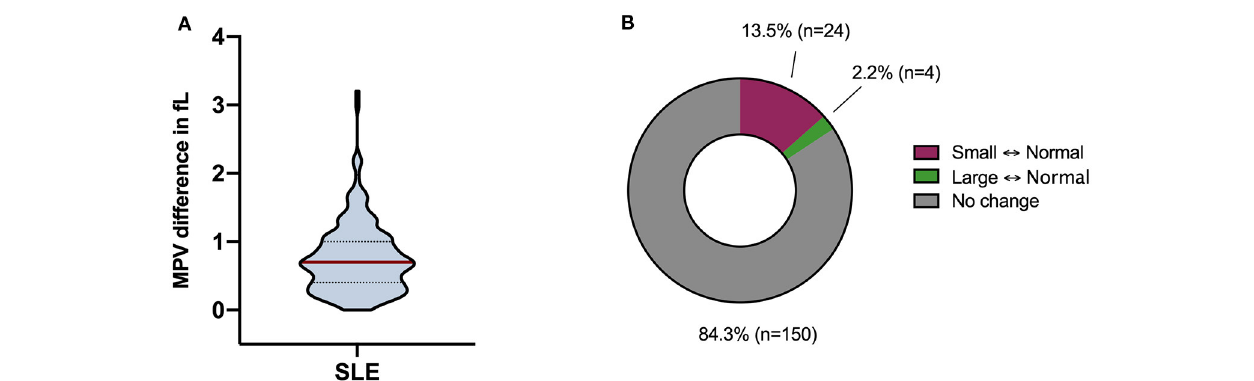
FIGURE 2 | Mean platelet volume (MPV) fluctuations. (A) Differences in MPV over time were calculated for each patient and illustrated through a violin plot. The MPV varied with a median of 0.7 fL (range 0–3.2 fL). The red line represents the median and the dotted lines represent the quartiles. (B) Transfer between the reference interval groups (i.e., small, normal, and large) longitudinally. Twenty-four (13.5%) patients changed between normal and small, and 4 (2.2%) patients shifted between normal and large. The rest of the patients (84.3%, n = 150) stayed within their reference interval group over time.